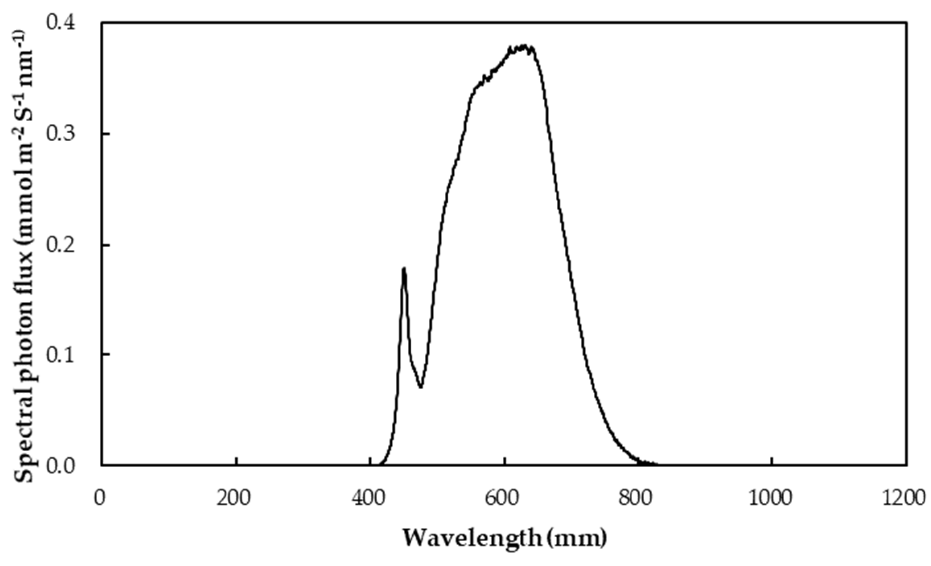
Figure 2. The spectral distribution of white LEDs used in this experiment. Light spectral scan was measured at center of the tray in photosynthetic photon flux (PPF) 150 μmol ‧ m −2 ‧ s −1 .